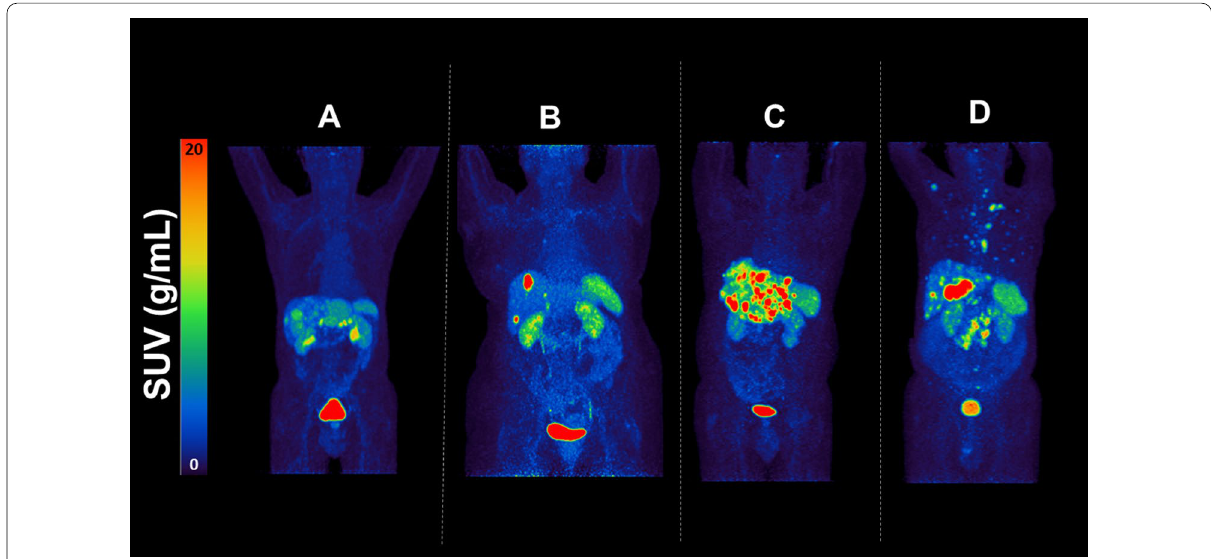
Fig. 1 Maximum intensity projections of patient 1–4 ( A – D ) at baseline whole‑body 68 Ga‑DOTATOC showing SUV values, where red color represents SUV of 20 and blue SUV of